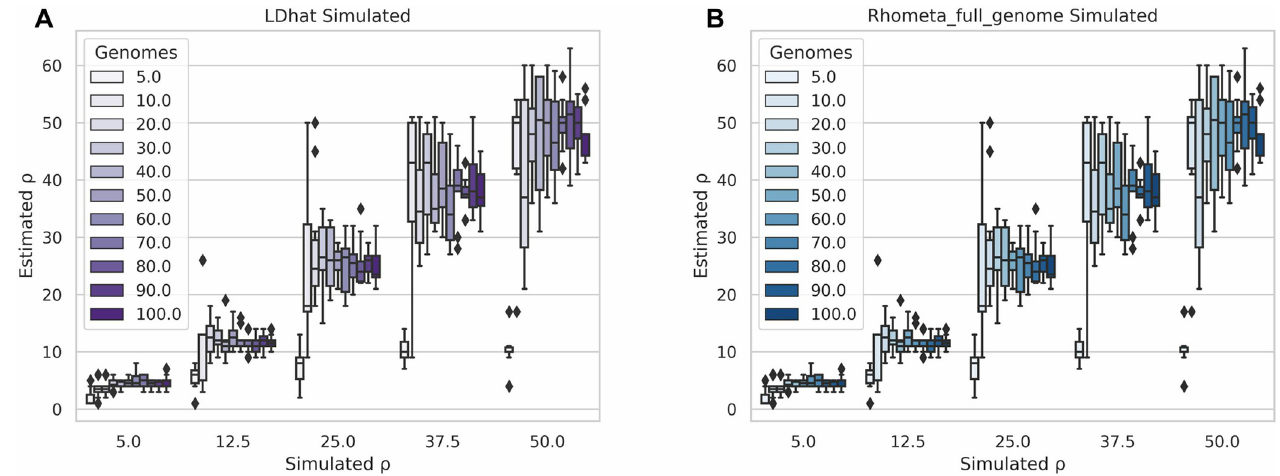
Fig 2. Comparison of LDhat and Rhometa_full_genome when running on simulated full genomes. ( A ) LDhat. Simulated vs Estimated population recombination rate ( ρ ) for varying number of simulated full bacterial genome sequences. ( B ) Rhometa_full_genome. Simulated vs Estimated population recombination rate ( ρ ) for varying number of simulated full bacterial genome